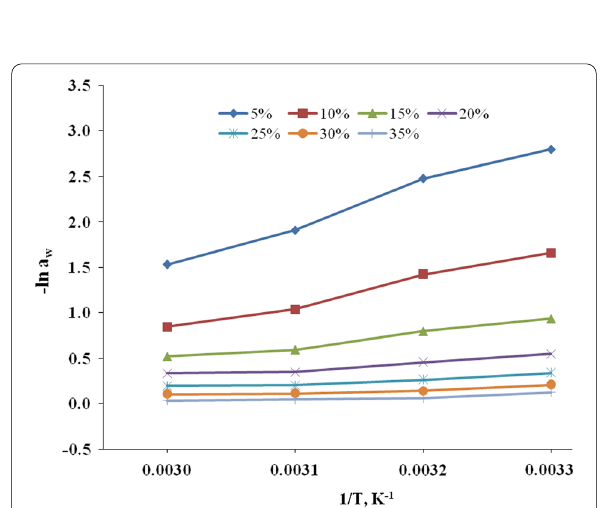
Fig. 6 Sorption isosteres of karaya gum at different moisture content